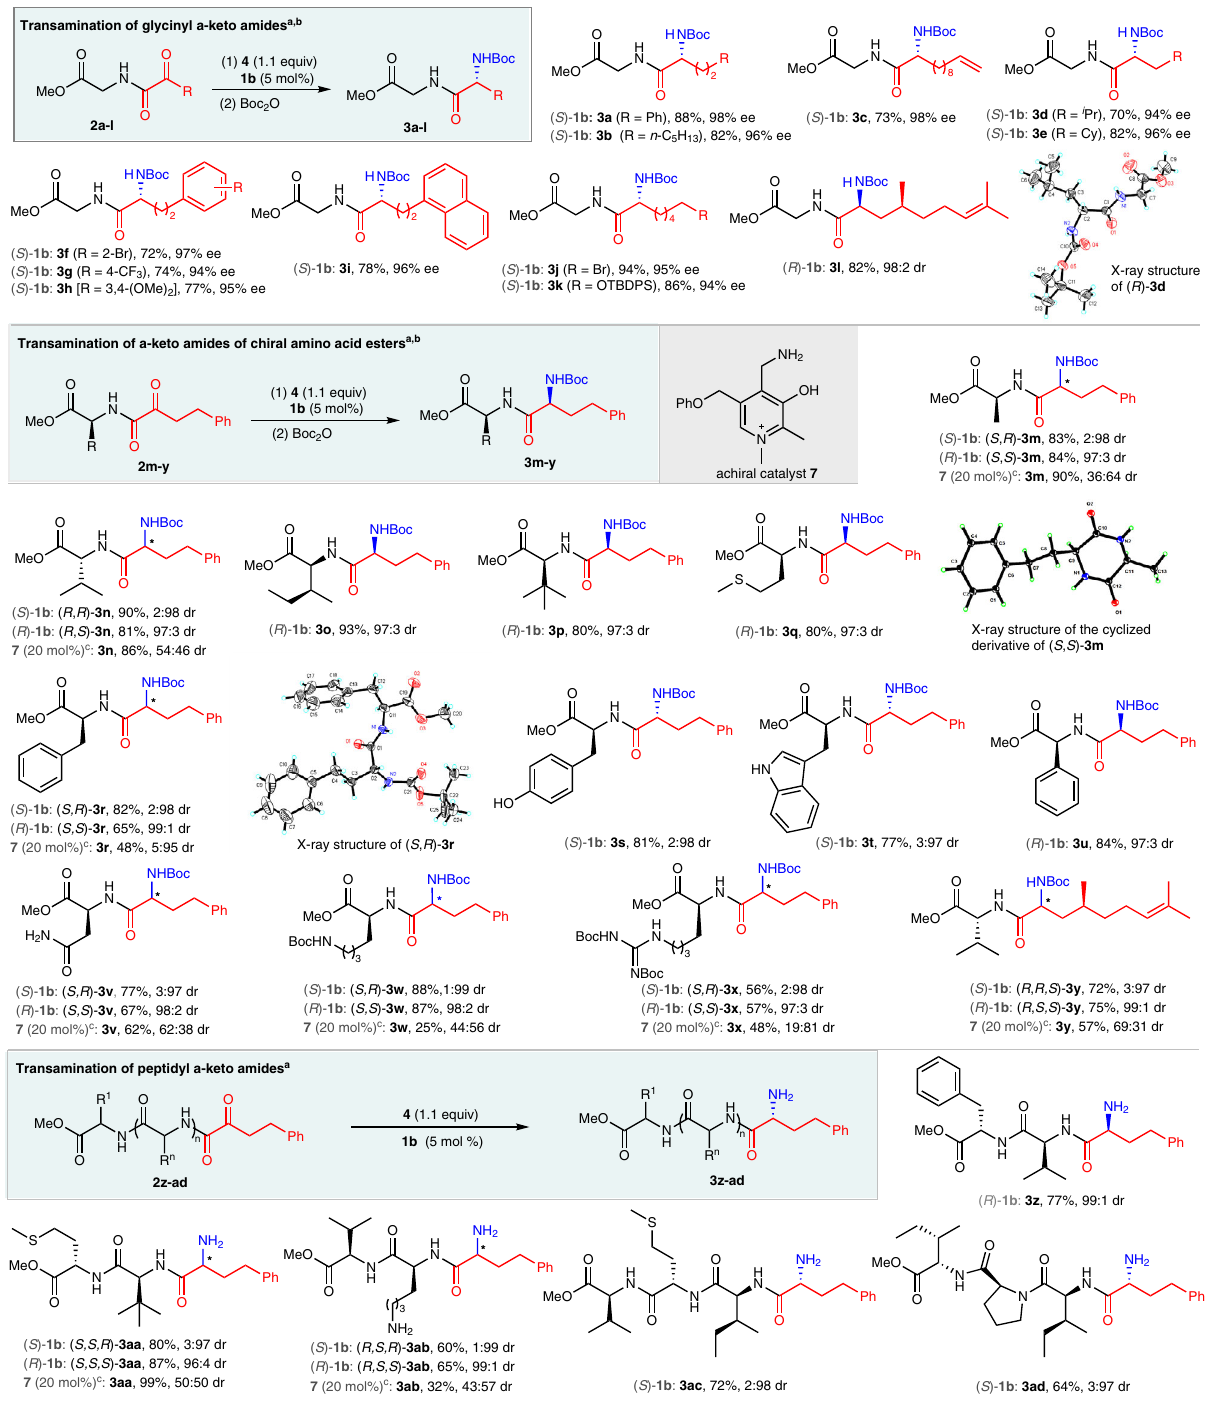
Fig. 4 Asymmetric biomimetic transamination of α -keto amides. TBDPS = tert -butyldiphenylsilyl. a Reaction conditions: 2 (0.10 mmol), 4 (0.11 mmol), 1b (0.0050 mmol), HOAc (0.40 mmol), Na 2 HPO 4 or KOAc (0.20 mmol) in CF 3 CH 2 OH or MeOH (0.48 mL) and H 2 O (0.12 mL) for 48 or 72 h unless otherwise stated (See SI). For 3m - y , the reactions were carried out in a double scale. Isolated yields were based on α -keto amides 2 . The ee and dr values were determined by HPLC analysis. b The crude reaction mixture was treated with di- tert -butyl dicarbonate (0.30 mmol) at room temperature for 3 h. c The reaction was carried out in a double scale with 7 (0.040 mmol, 20 mol %) at 50 °C for 72